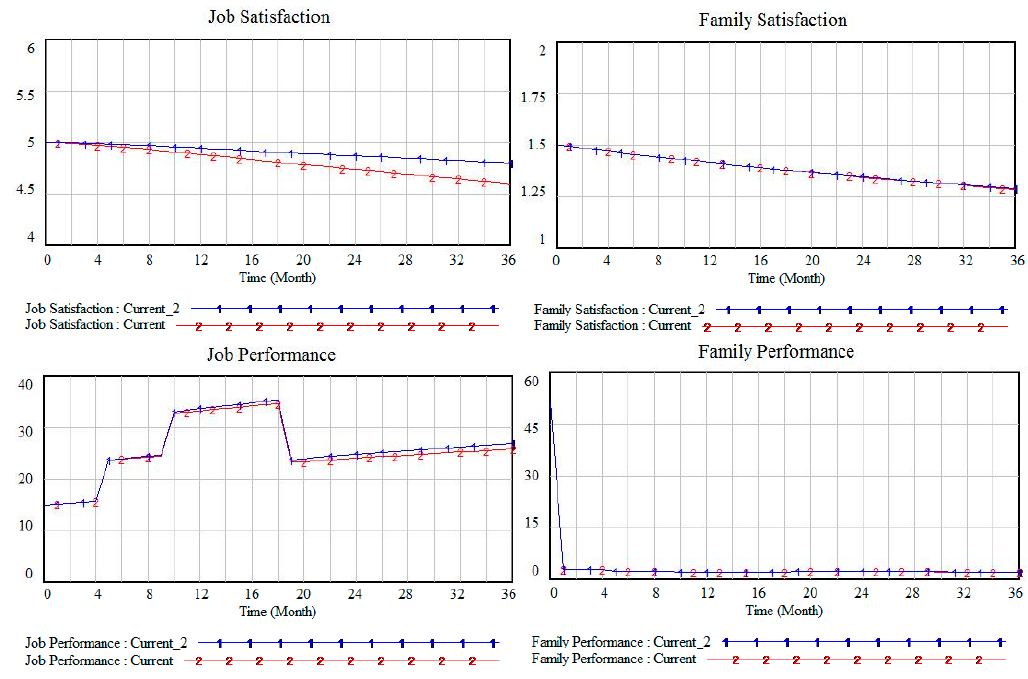
Figure 7. Satisfaction and performance under different family support.